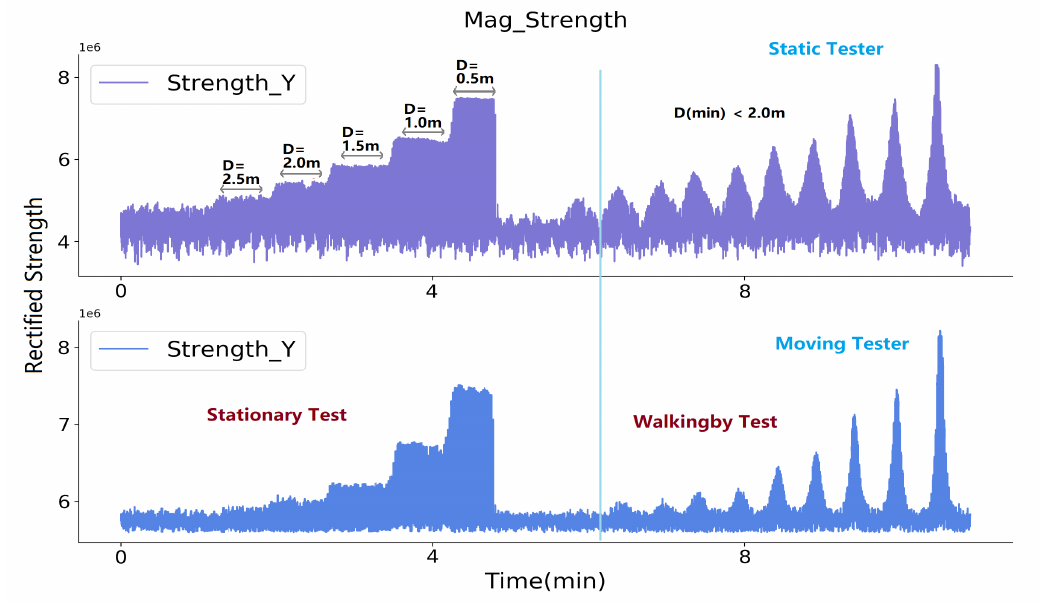
Figure 10. Detection range test with two body-worn prototypes activated. One in stationary state and another in mobile state.